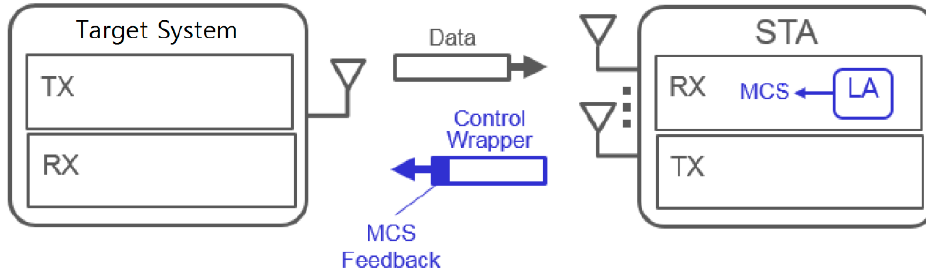
Figure 2. Ideal link adaptation.